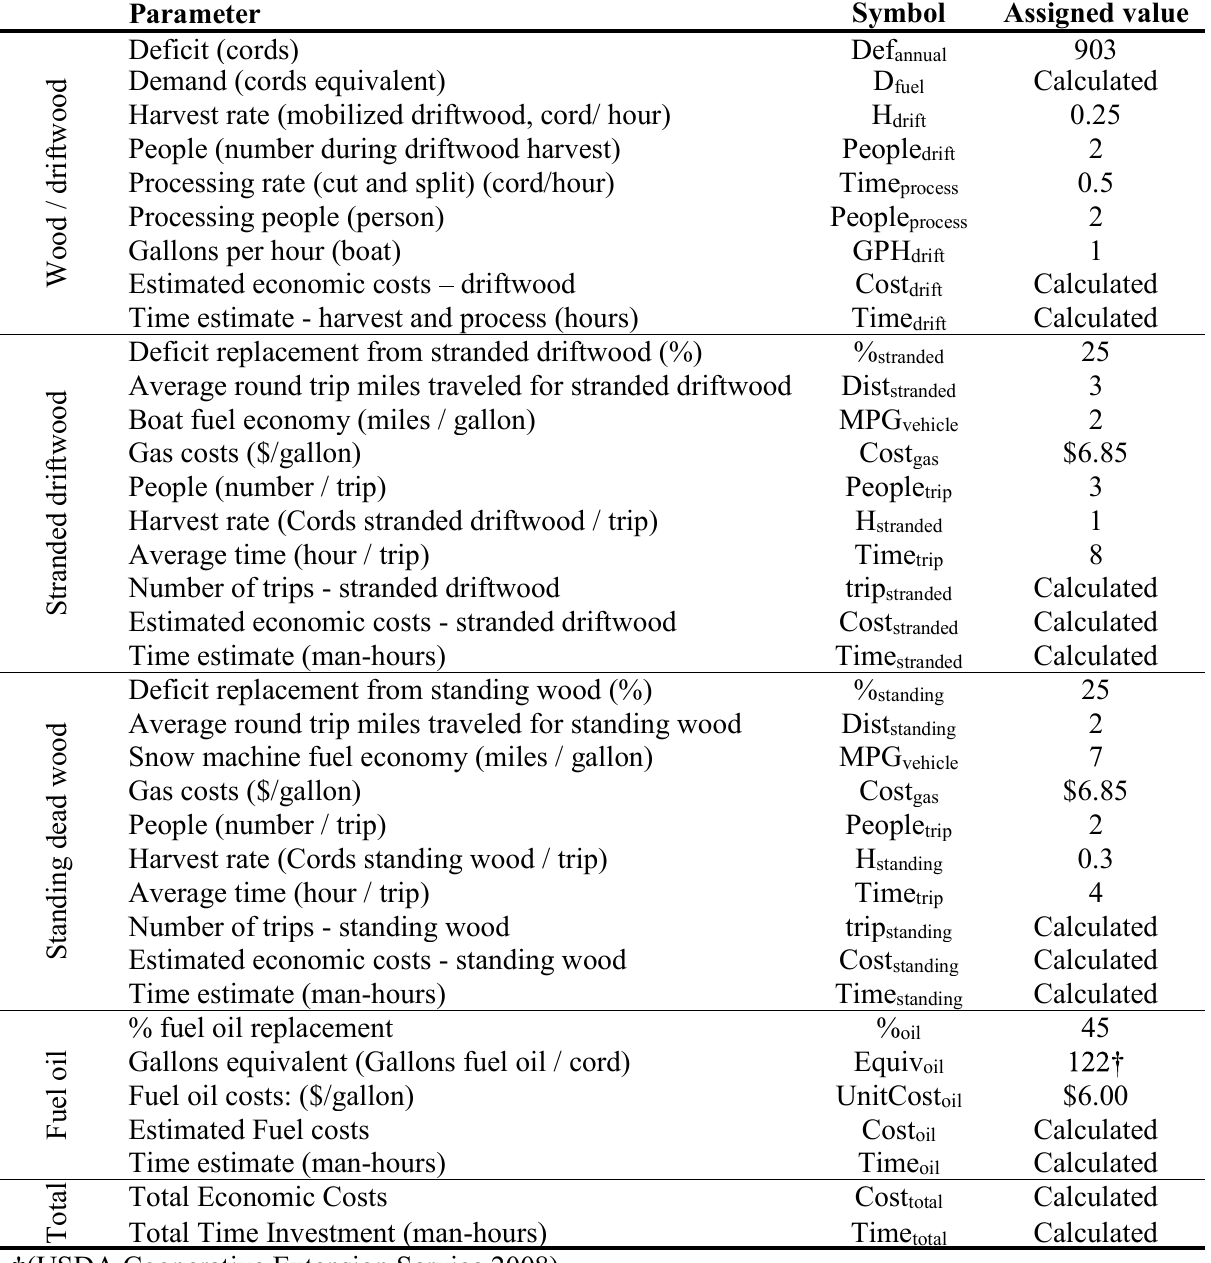
Table A1.1. Input and output parameters for the economic analyses of the driftwood harvest